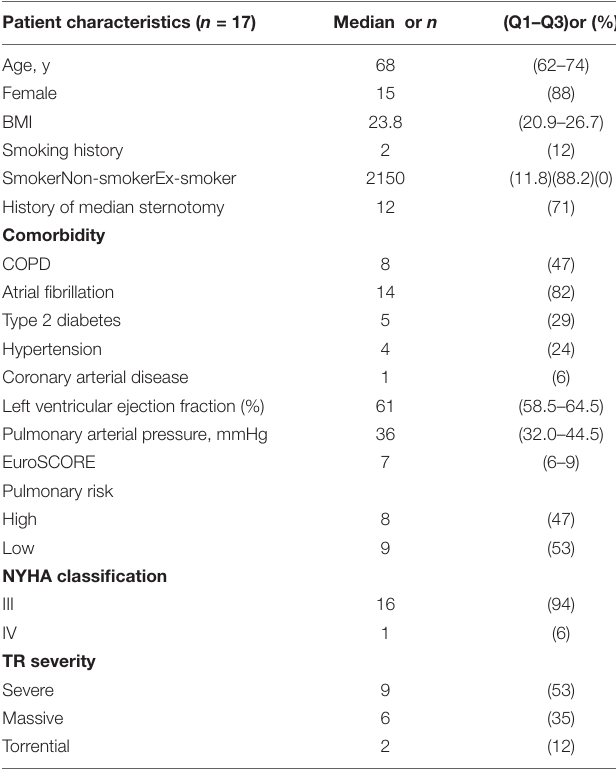
TABLE 1 | Demographic and patient clinical characteristics recorded on